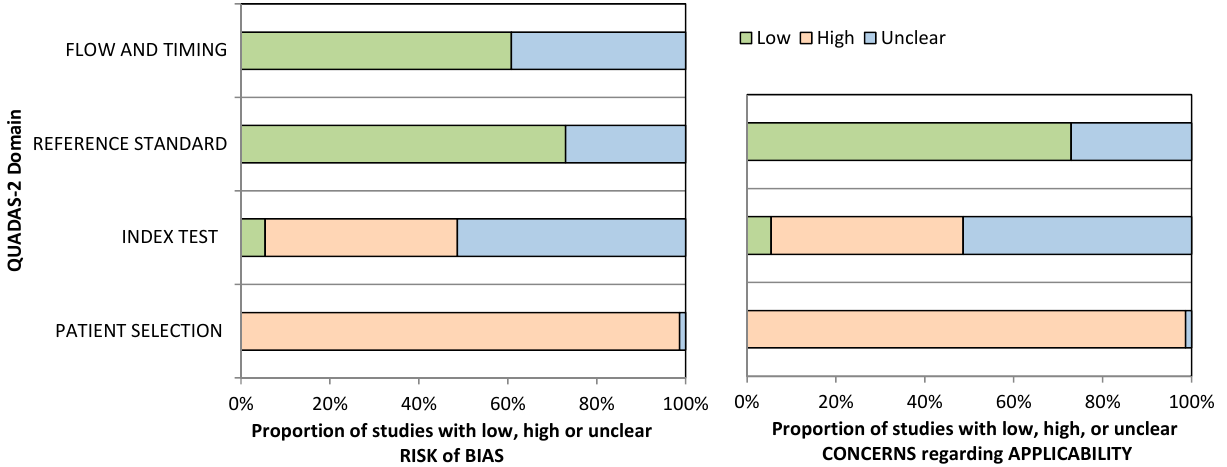
Figure 6. QUADAS-2 quality assessment overview for the included studies.